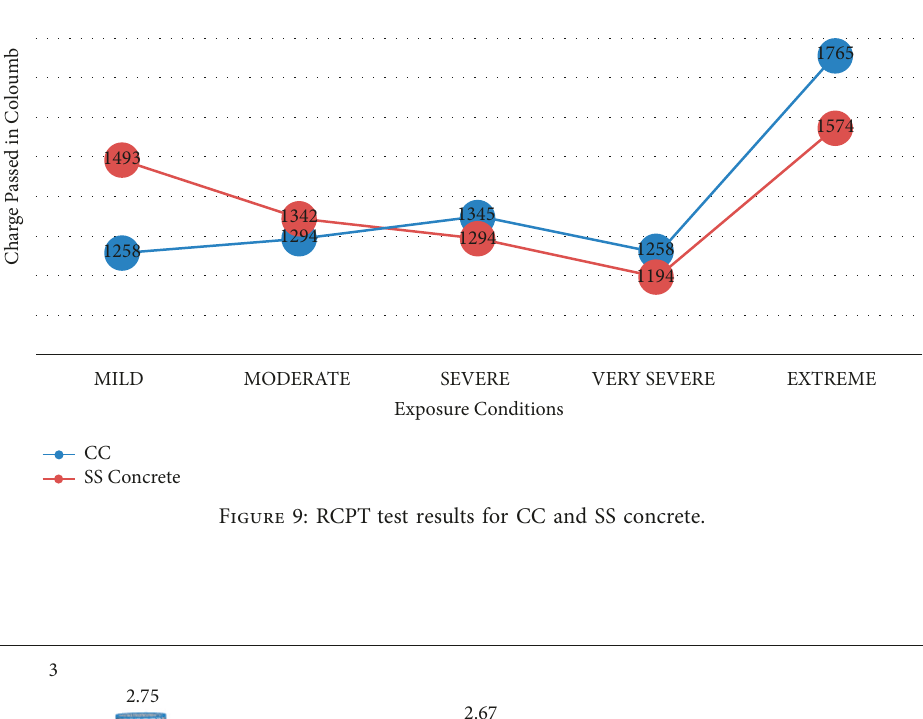
Figure 9: RCPT test results for CC and SS